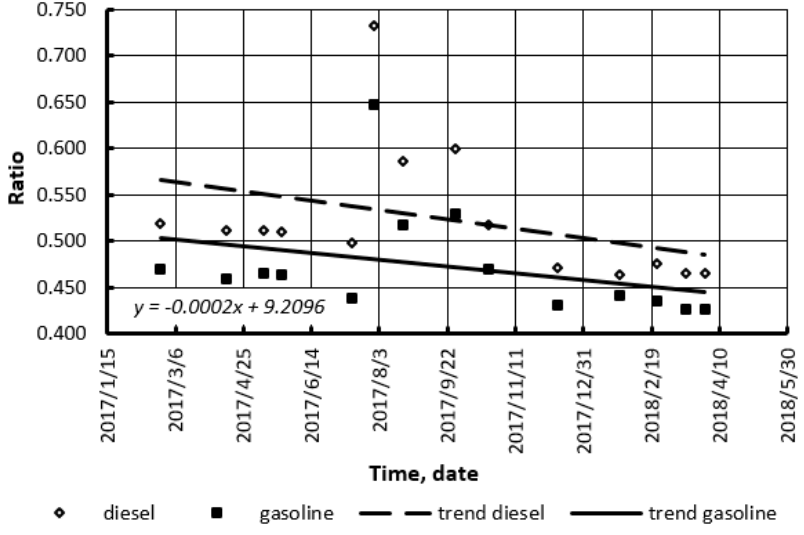
Figure 6. LPG/conventional fuel prices ratio in Ukraine.